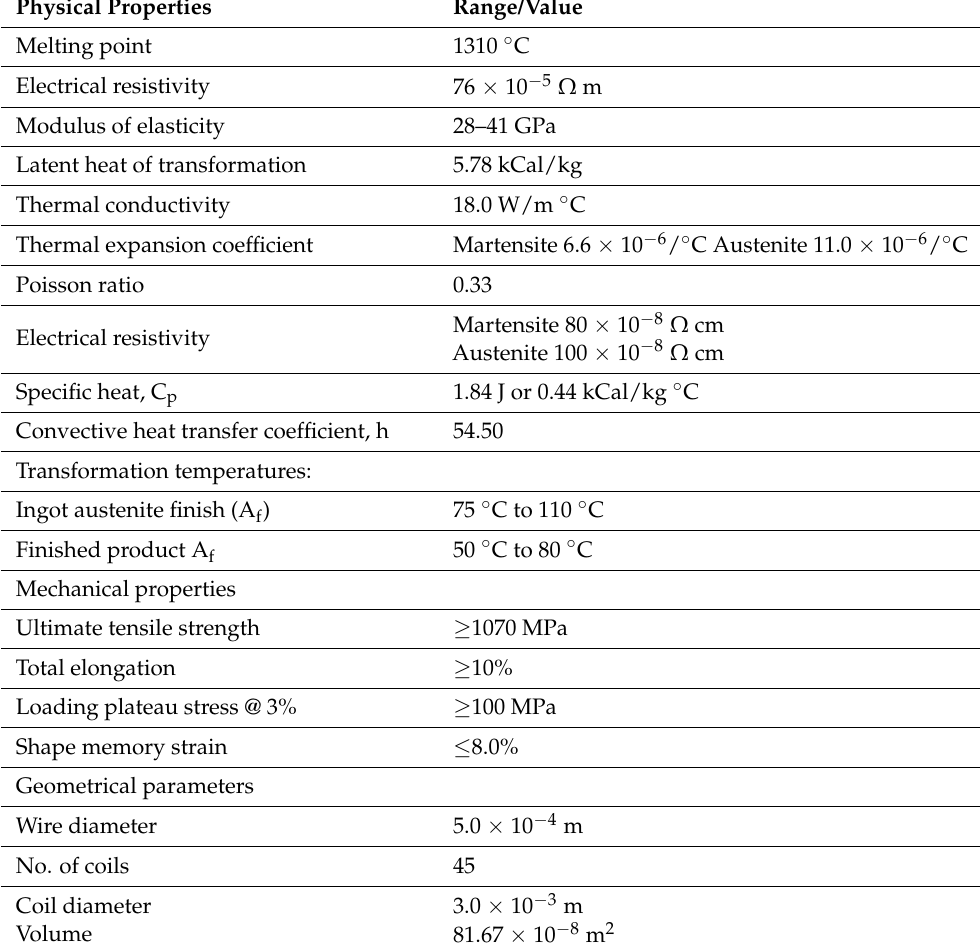
Table 2. Specifications of the